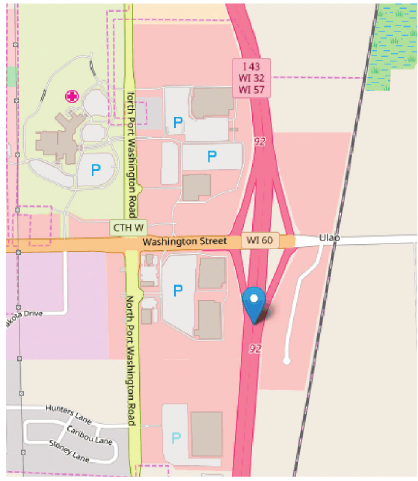
Figure 5: The traffic data collection station in a city of Wisconsin.